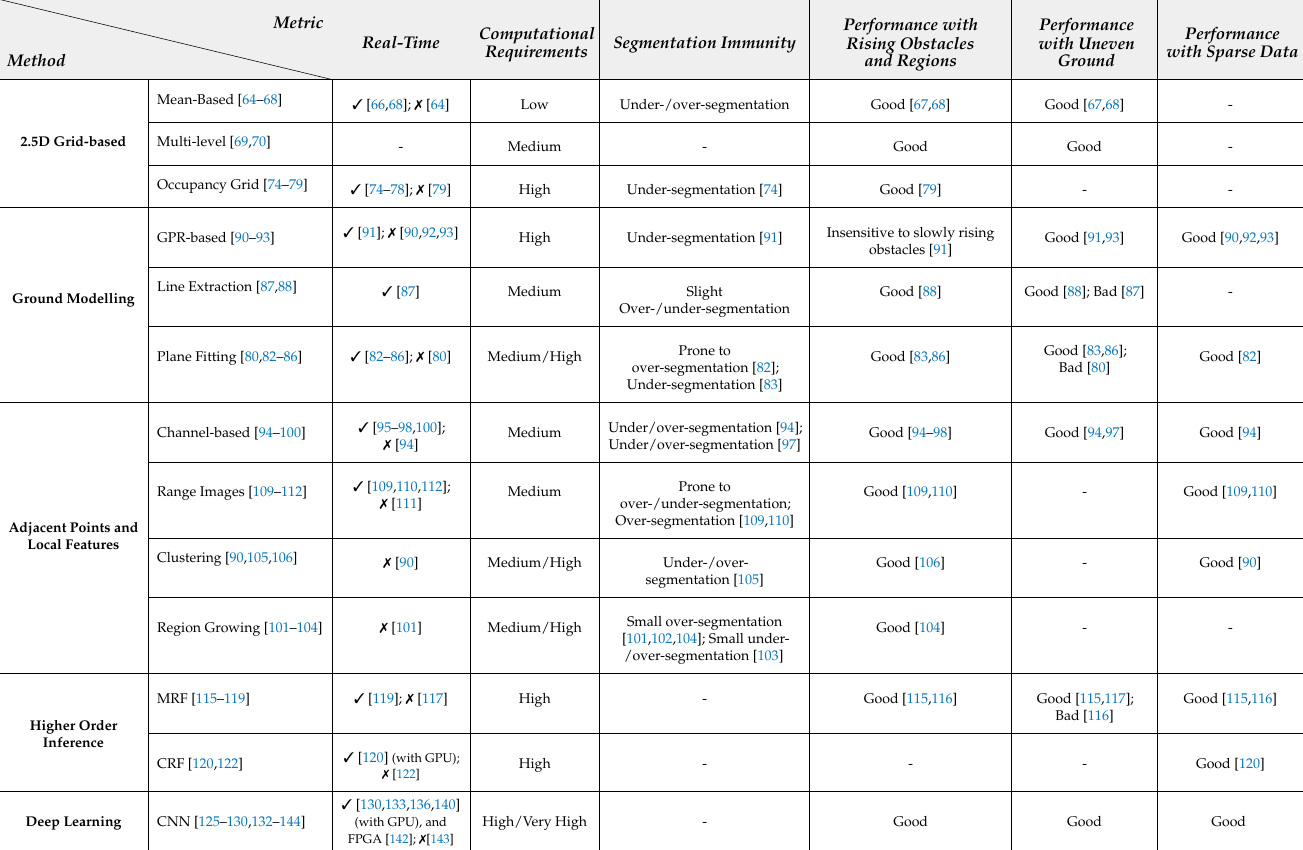
Table 1. Qualitative comparison between existing ground segmentation methods.